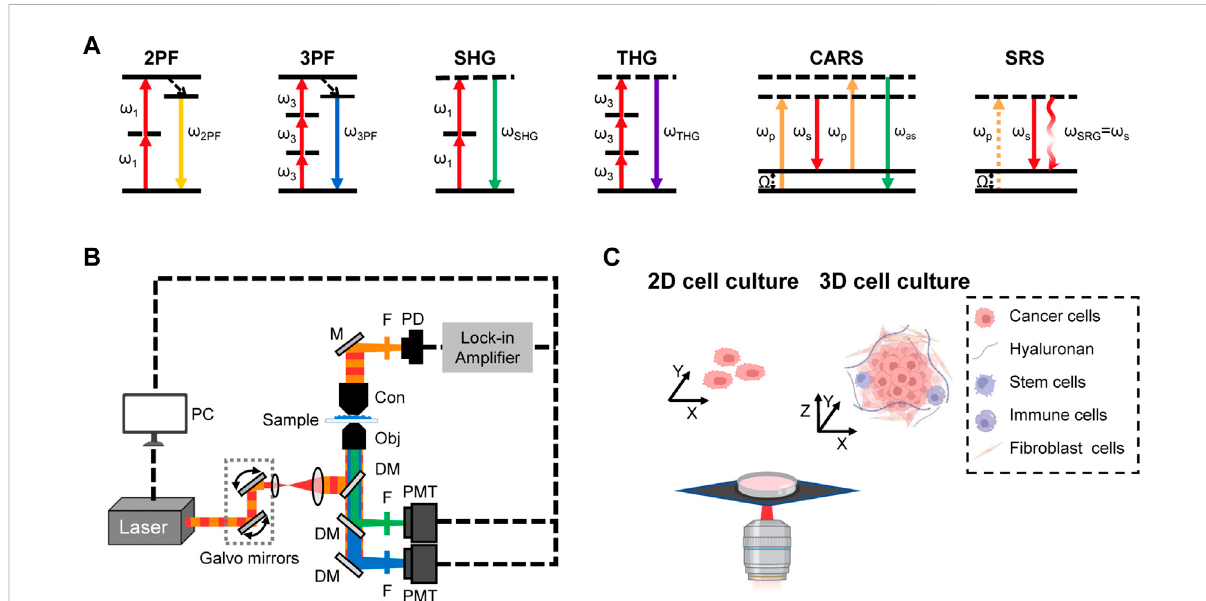
FIGURE 1 Illustration of multimodal label-free NLO imaging of cell cultures (A) Energy diagrams of NLO modalities. (B) Schematic of multimodal NLO microscope. M,mirror;F, fi lter;Obj,objective;Con,condenser;DM,dichroicmirror;PMT,photomultipliertube;PD,photodiode. (C) 2Dcellcultures and 3D cell cultures with heterogenous cell